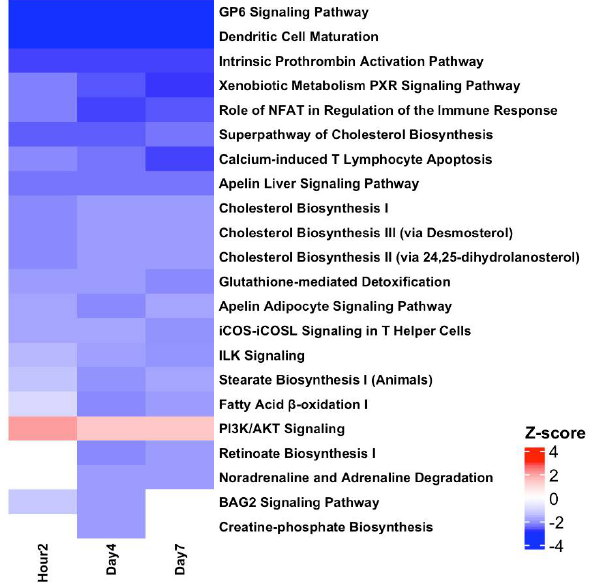
Figure 8. Significantly (Abs z-score ≥ 2 and −log p ≥ 1.3) modulated pathways in at least one time point from the analysis of SDTGs ( p ≤ 0.05 and Abs FC ≥ 2) after lethal IR dose exposure at all